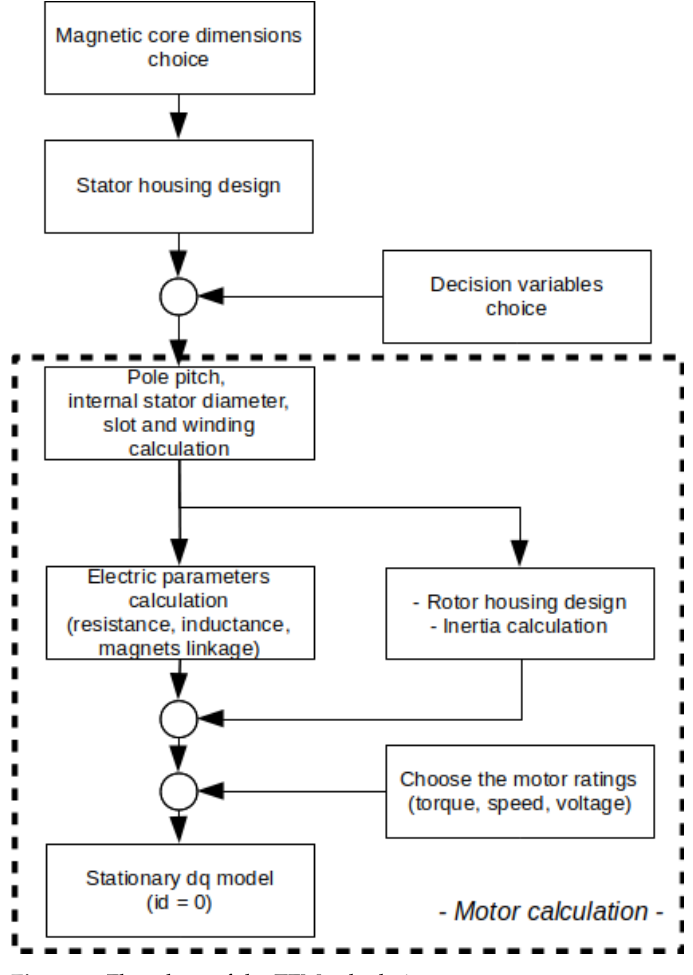
Figure 2. Flowchart of the TFM